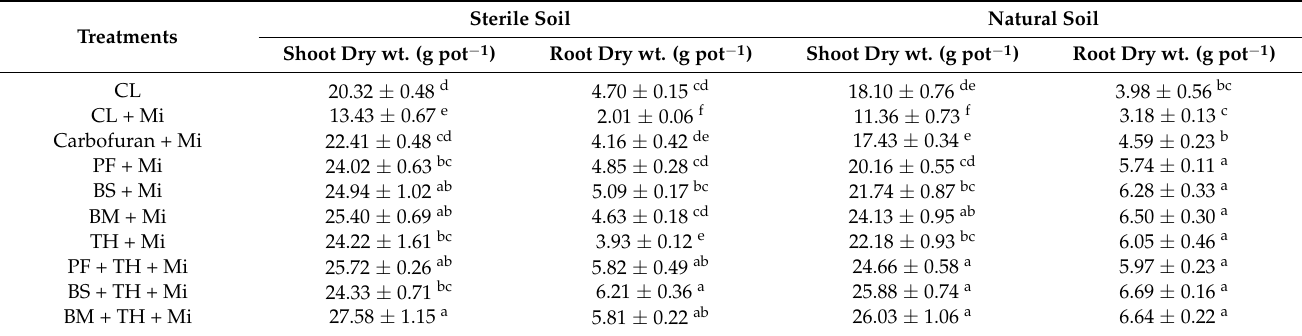
Table 3. Dry biomass of O. basilicum (g pot − 1 ) treated with different bioinoculants and grown under different soil conditions. Sterile Treatments